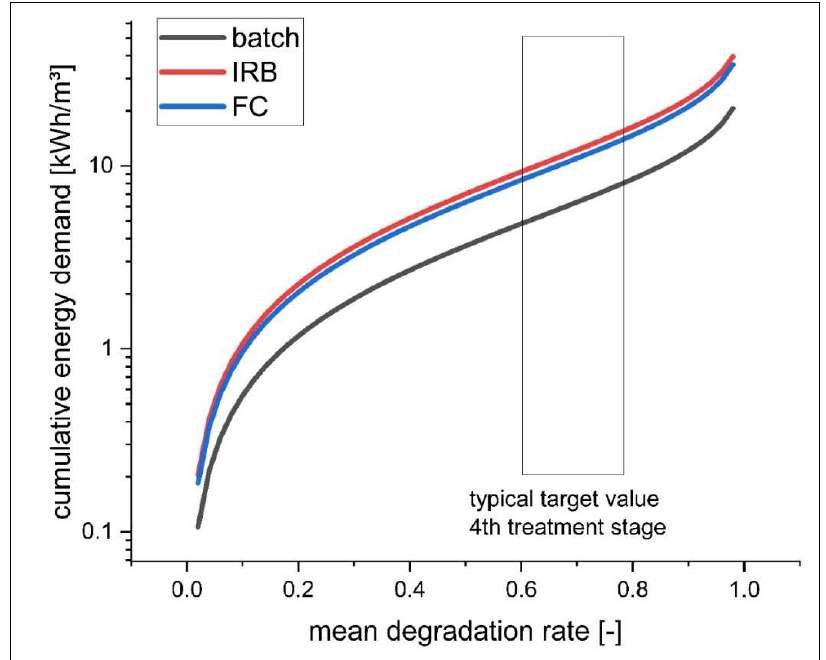
Figure 10. Energy demand per volume treated of the batch, flat cell (FC), and immersion rotary body reactor (IRB) in relation to the mean degradation rate of all measured micro-pollutants.